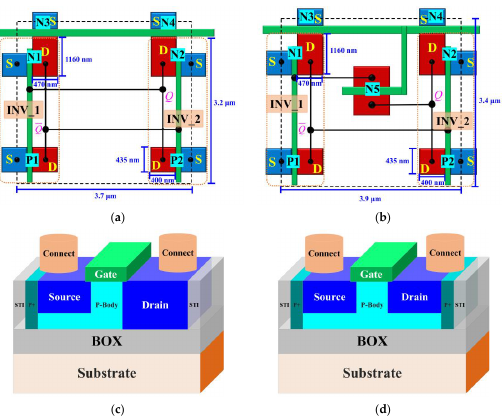
Figure 1. Schematics of memory cell structure of ( a ) 6T SRAM, ( b ) 7T SRAM, ( c ) BUSFET (body under source FET) structure of N1, N2, N3, N4, P1, P2, and ( d ) delay transistor N5 structure.